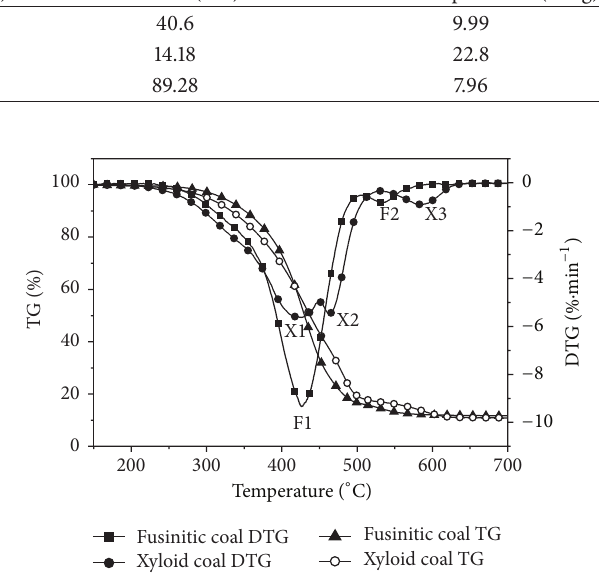
Figure 5: TG-DTG of SLR-X and SLR-F